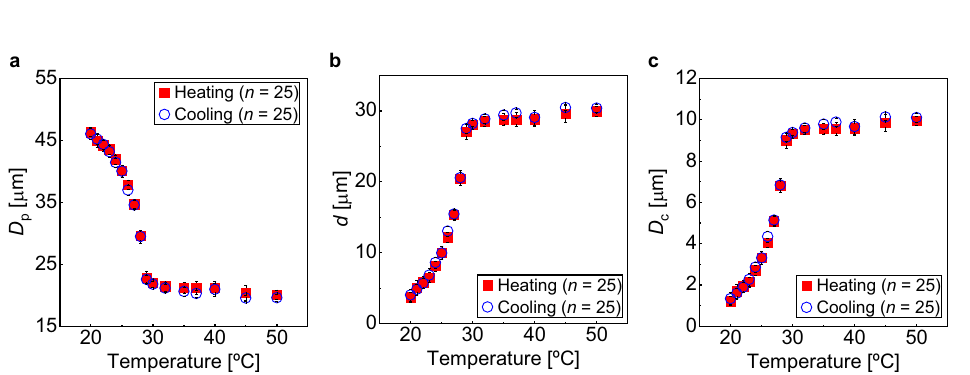
Figure 5. Thermal effects on ( a ) pillar diameters ( D p ), ( b ) gap between the two adjacent pillars ( d ), and ( c ) critical diameters ( D c ) calculated with Davis’s formula 39 , Eq. (1), of the DLD array. The filled rectangles